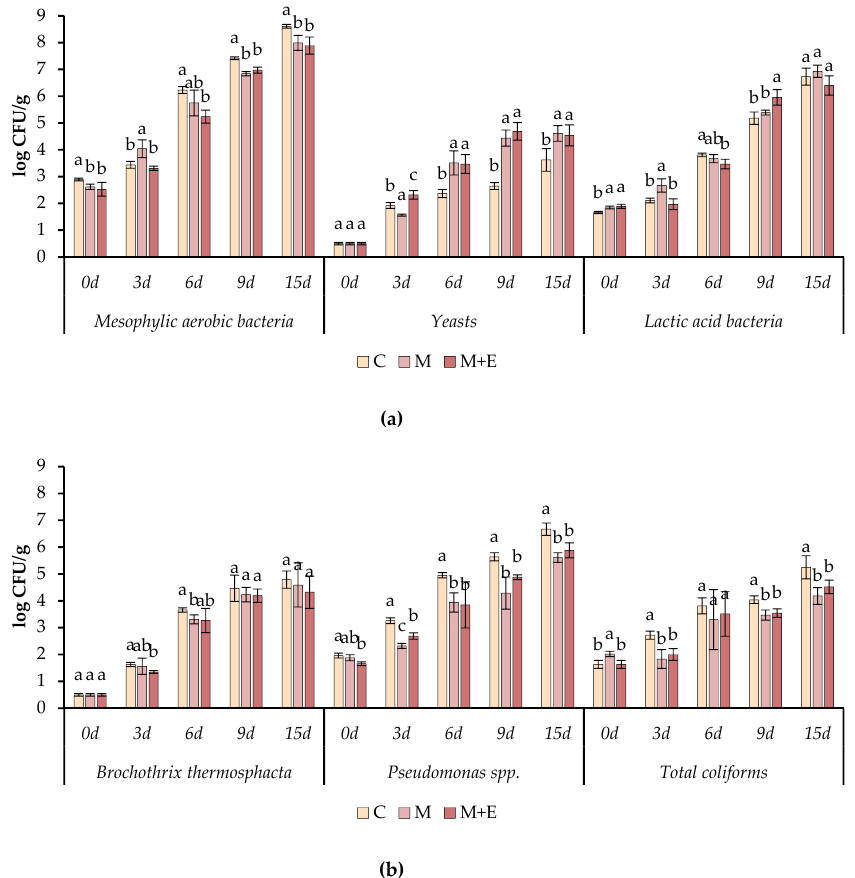
Figure 7. Cell load (log CFU/g ± SD), during the refrigerated storage, of total aerobic mesophilic bacteria, yeast and lactic acid bacteria ( a ) Brochothrix thermosphacta , Pseudomonas spp. and total coliforms ( b ) in di ff erent pork loin slices: Control (C), Marinated (M), marinated with essential oils (M + O). Data represent means ± SD. a-b-c = for each microorganism, at the same time of storage, average values lacking a common letter significantly di ff er among the same sampling time ( p <